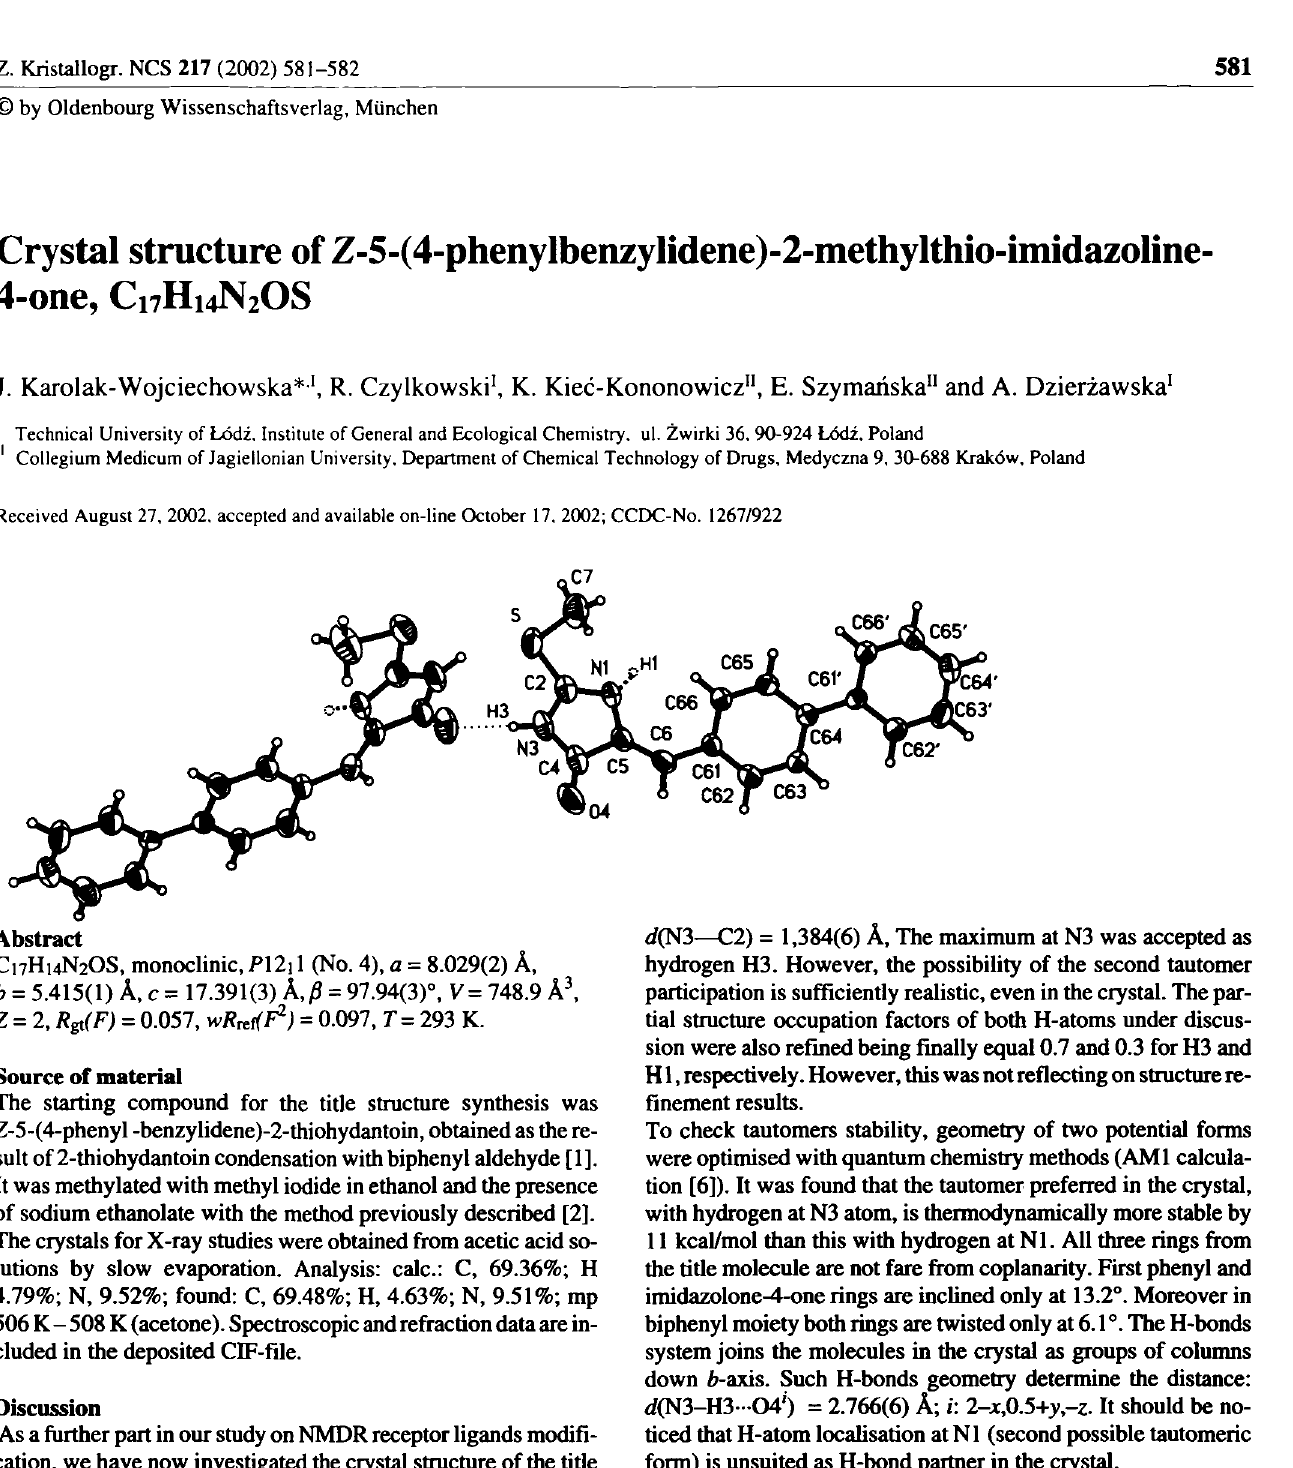
Table 1. Data collection and handling. Crystal: